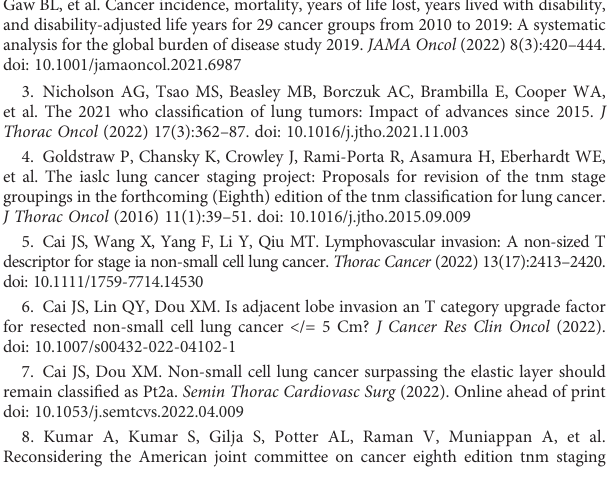
SUPPLEMENTARY FIGURE 2 Prognostic variables selection using the LASSO regression model in the T3- Add& T2a pair after PSM. LASSO coef fi cient pro fi les of 14variables against the log (Lambda) sequence for overall survival (A) and cancer speci fi c survival (C) . Tuning parameter (Lambda) selection in the LASSO model used 10-fold cross-validation via minimum criteria (overall survival: (B) cancer speci fi c survival: (D) . LASSO, least absolute shrinkage and selection operator; PSM, propensity score matching. SUPPLEMENTARY FIGURE 3 Prognostic variables selection using the LASSO regression model in the T3- Add&T2b pairafterPSM. LASSOcoef fi cientpro fi lesof14variablesagainstthe log (Lambda) sequence for overall survival (A) and cancer speci fi c survival (C) . Tuning parameter (Lambda) selection in the LASSO model used 10-fold cross-validation via minimum criteria (overall survival: (B) cancer speci fi c survival: (D) . LASSO, least absolute shrinkage and selection operator; PSM, propensity score